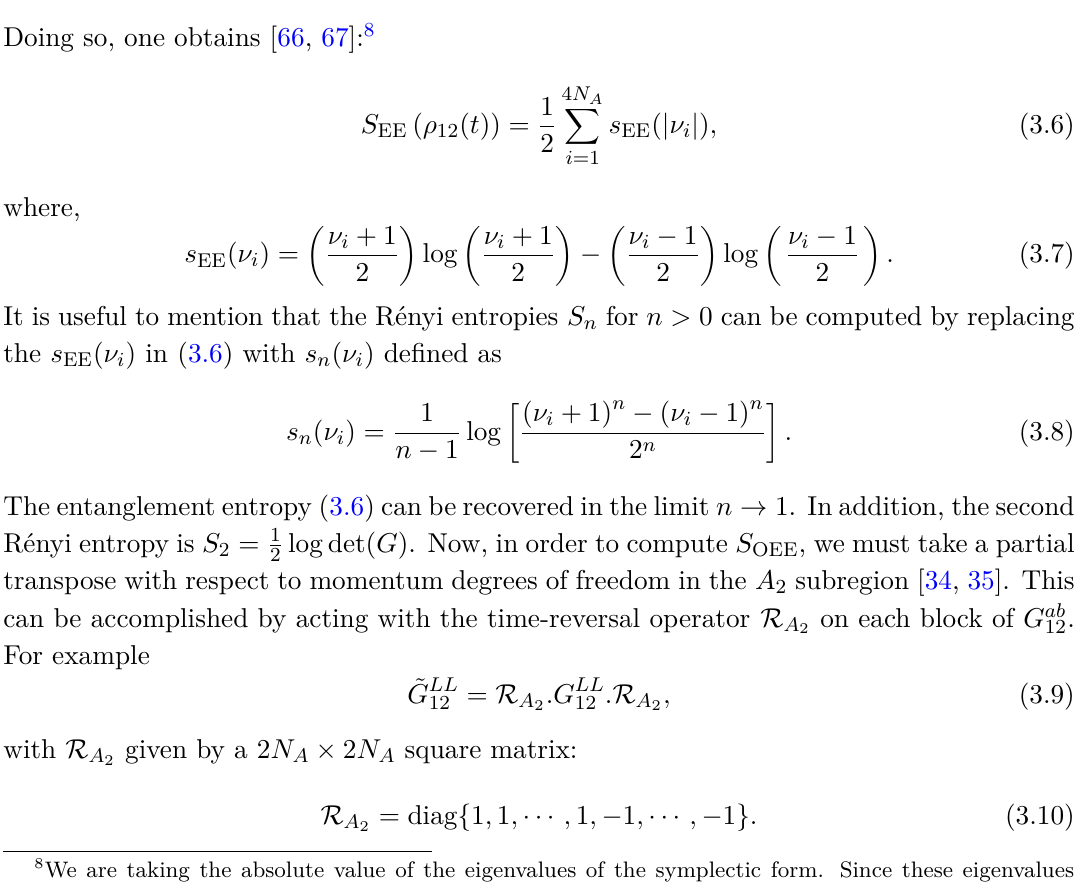
Figure 1 . Our setup for the decomposition of the system is depicted in this figure. We have taken N sites on each side and the total subsystem consists of four spatially disconnected regions: two intervals on the left ( A ) with the separation d and the corresponding (identical) intervals and the L same separation on the right ( A ) with N sites on each R A